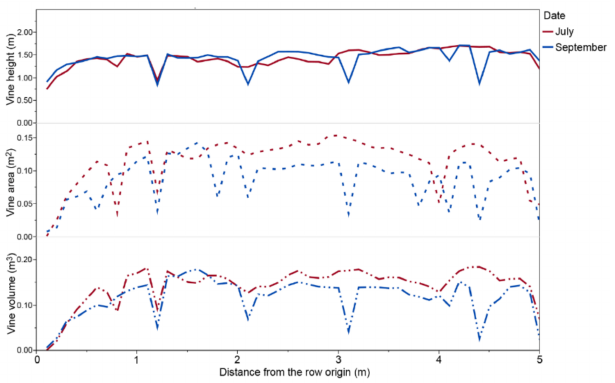
Figure 9. Height, area, and volume values in two dates (July and September, corresponding to different growth stages) from the left side to the row. Every data corresponded to 0.10 m length segments of the vine